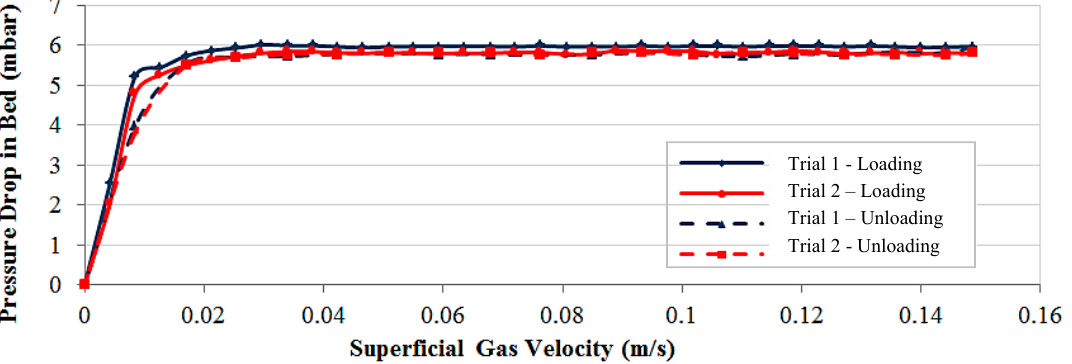
Figure 4. Two independent fluidization tests - Loading (—) and Unloading ( ‒ ‒ ) of fine powder bed (CALCIT MVT-100).